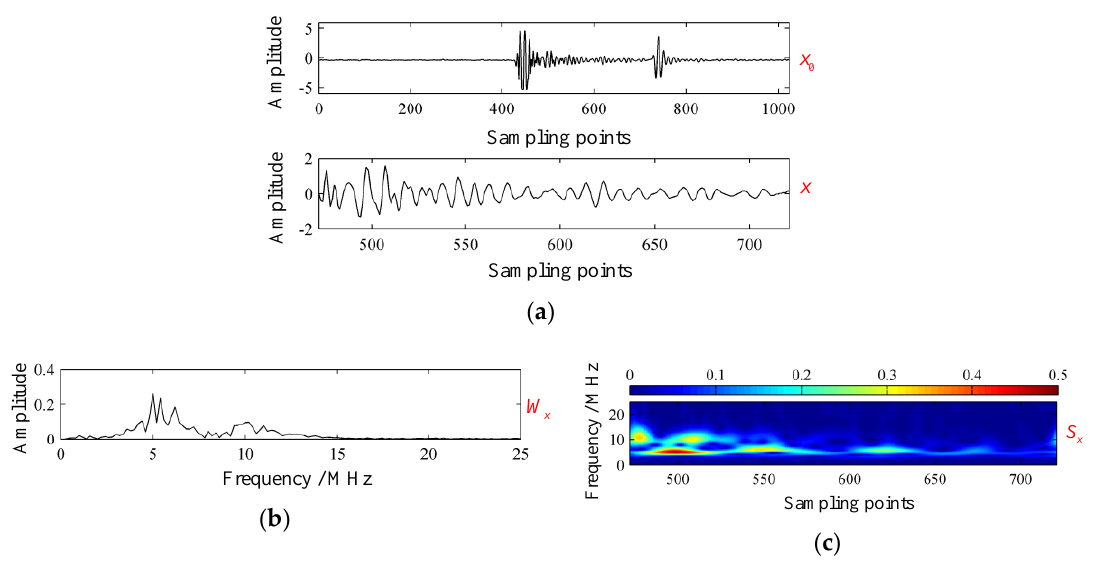
Figure 8. Acoustic characterization of experimental signal. ( a ) Waveform; ( b ) spectrum; and ( c ) GST spectrum.